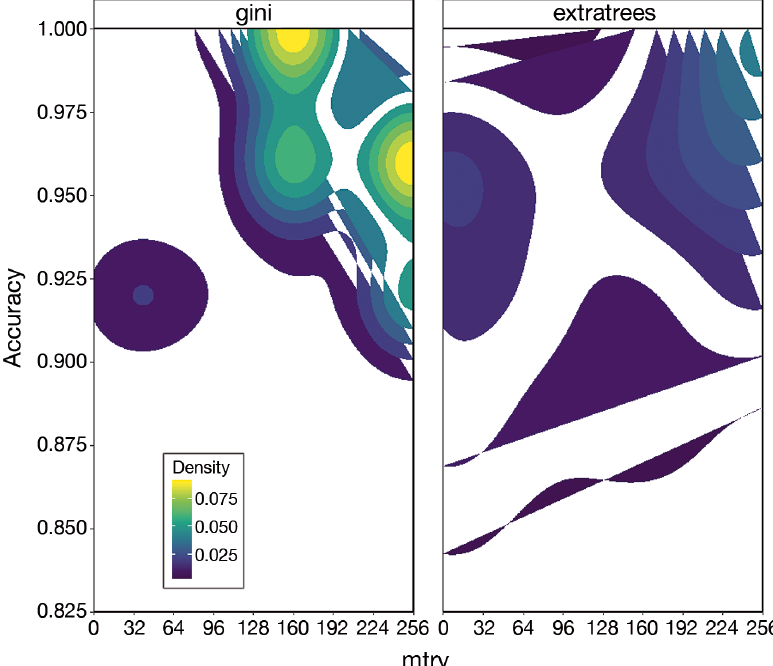
Fig. 2. Test set performance of predictive models with randomized seed states. Shown are the prediction accuracies of trained models on test set data, with the number of randomly selected features as split candidates (‘mtry’) indicated on the horizontal axis. The density of models reporting similar performance and hyperparameters is indicated by warmer colors. The left and right plots corre- spond to gini and extratrees (‘splitrule’), respectively, which determine how the algorithm creates decision tree